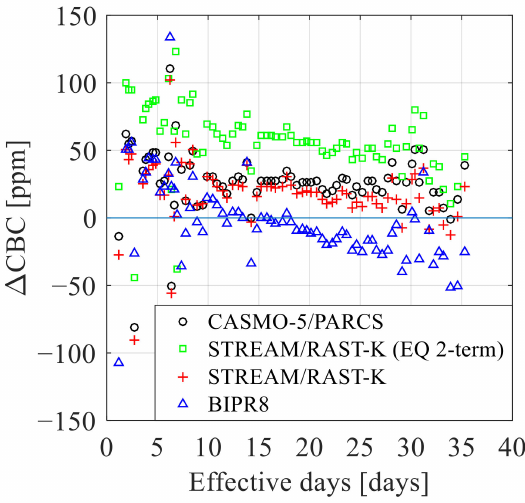
Figure 21. Absolute difference of boron concentration with